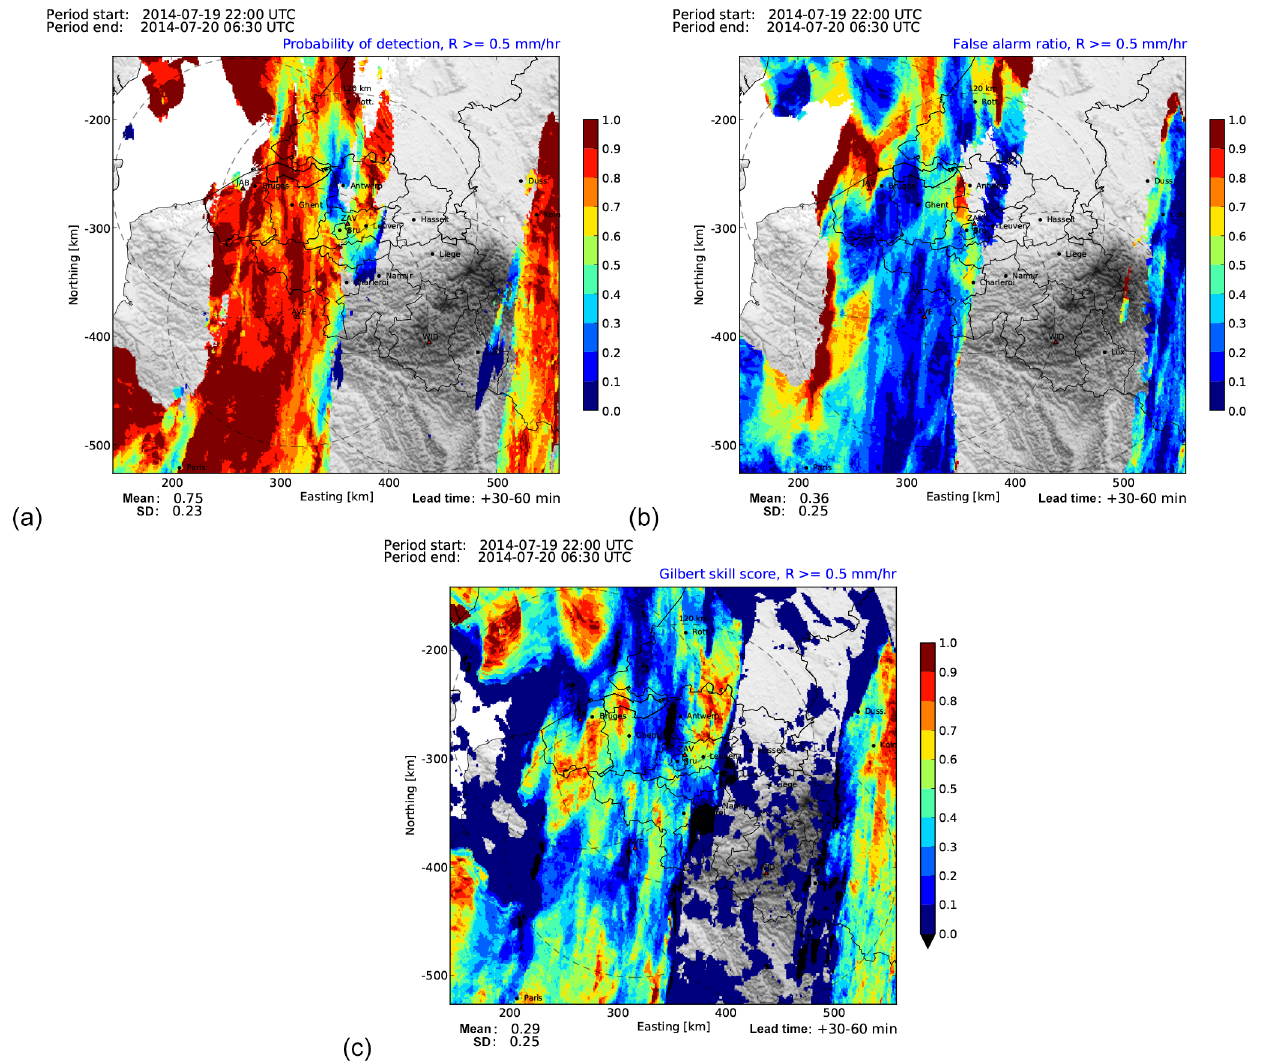
Figure 6. (a) POD, (b) FAR and (c) GSS of the 30–60min ensemble mean forecast of exceeding 0.5mmh − 1 for the Leuven case on 19–20 July